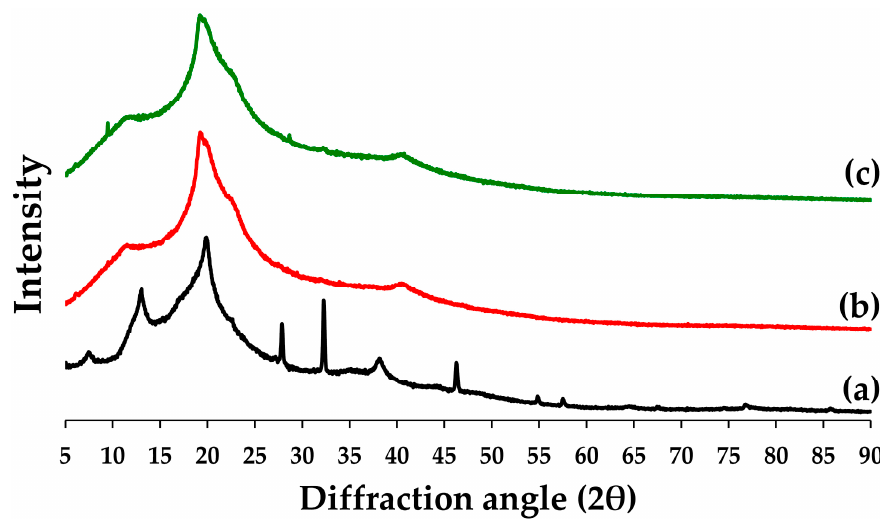
Figure 12. XRD patterns of ( a ) silver-nanoparticle-complexed G. applanatum , ( b ) blank film, and ( c ) topical film containing silver-nanoparticle-complexed G. applanatum . SEM